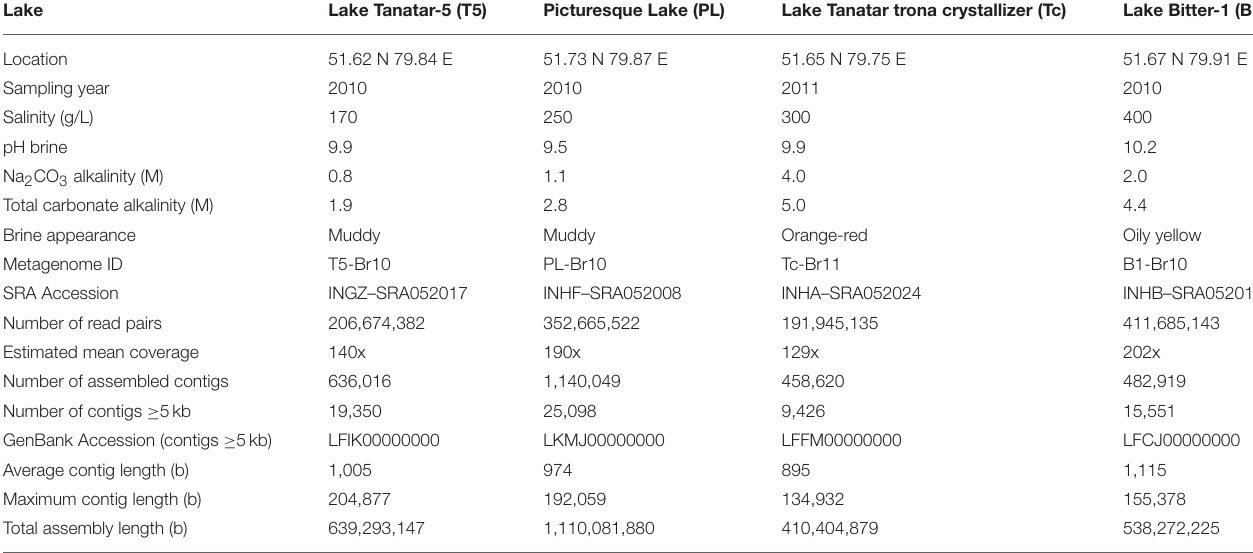
TABLE 1 | General features of the sampled soda lakes, the obtained metagenomic raw sequence reads, and the assembled